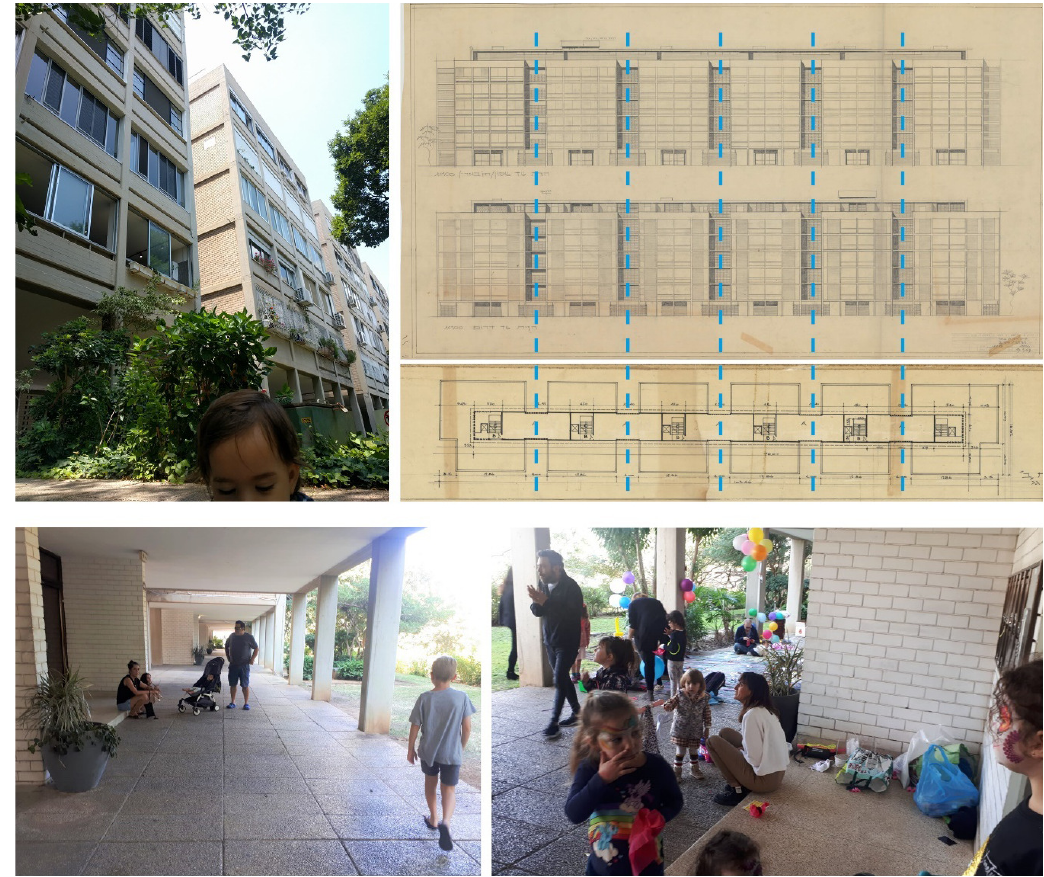
Figure 8. Facades and roof plan of one of the elongated buildings (40–50 Be’eri street). Note in the facades the recessed service balconies (dark grey) shaping the large building as a series of separate‐looking volumes. Top: the facades’ draw‐ ing, 1963; Bottom: roof plan, unknown year, with graphic additions by the authors. The building’s design as a series of separate‐looking volumes softens the large building’s massiveness and produces a colonnade with extensive thresholds for each entry. Sources: A. Sharon (1963); photos by the